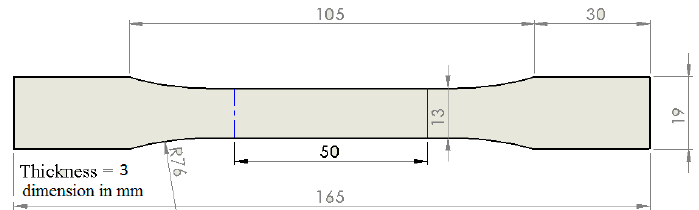
Figure 4. Specification of tensile test specimen according to ASTM D638-14. All dimensions in mm.